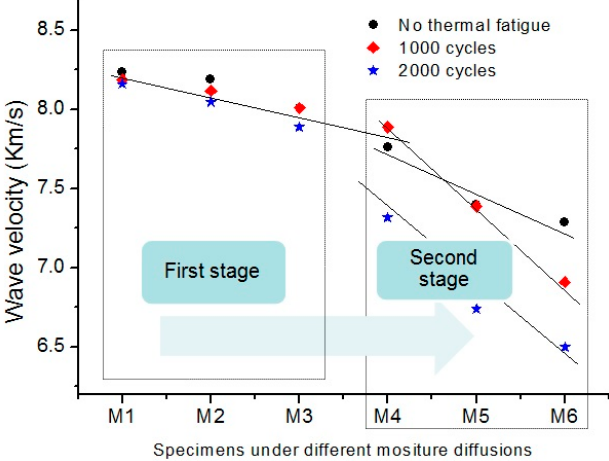
Figure 9. Variation of change rate of wave velocity in the different specimens subjected moisture